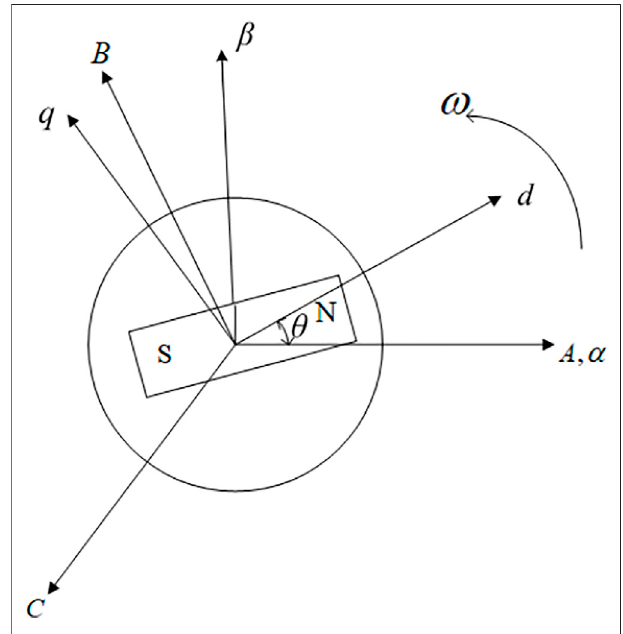
FIGURE 1 | Coordinates of